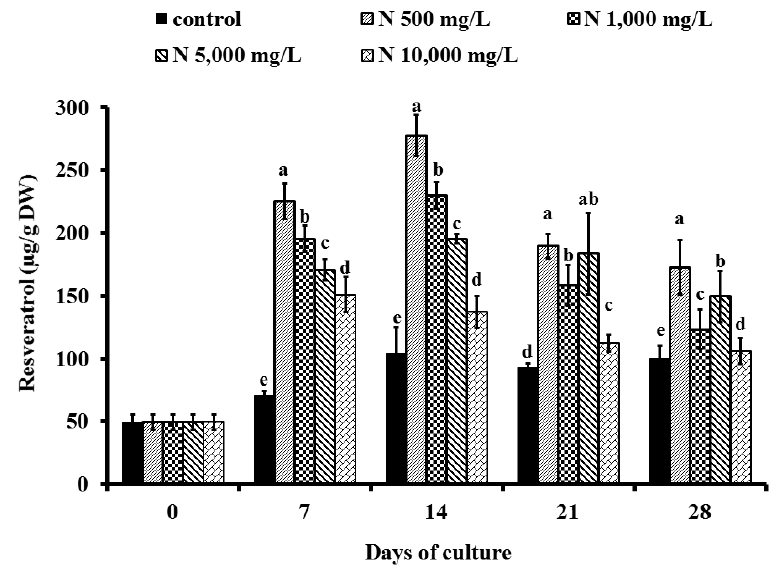
Figure 4. Effect of ammonium nitrate (control, N 500 mg/L, N 1,000 mg/L, N 5,000 mg/L and N 10,000 mg/L) on resveratrol contents (µg/g DW) of ‘Pok Dum’ Vitis vinifera cell suspension cultures. Data are mean ± SD ( n = 3). Means at each day of culture with the same letter do not differ according to Duncan’s New Multiple Range Test, p ≤